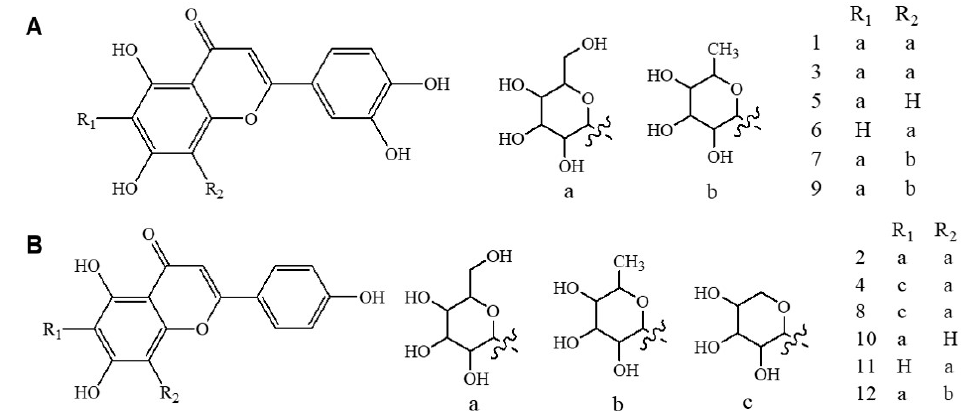
Figure 1. Chemical structures of luteolin derivatives ( A ) and apigenin derivatives in oil palm leaves (OPL) extract ( B ). Compound assignment: 1 , luteolin-6,8-di- C -hexose (Isomer 1); 3 , luteolin-6,8-di- C -hexose (Isomer 2); 5 , isoorientin; 6 , orientin; 7 , luteolin-6- C -hexose-8- C -deoxyhexose (Isomer 1); 9 , luteolin-6- C -hexose-8- C -deoxyhexose (Isomer 2); 2 , apigenin-6,8-di- C -hexose; 4 , apigenin-6- C -pentose-8- C -hexose (Isomer 1); 8 , apigenin-6- C -pentose-8- C -hexose (Isomer 2); 10 , vitexin; 11 , isovitexin; and 12 , apigenin-6- C -hexose-8- C -deoxyhexose.